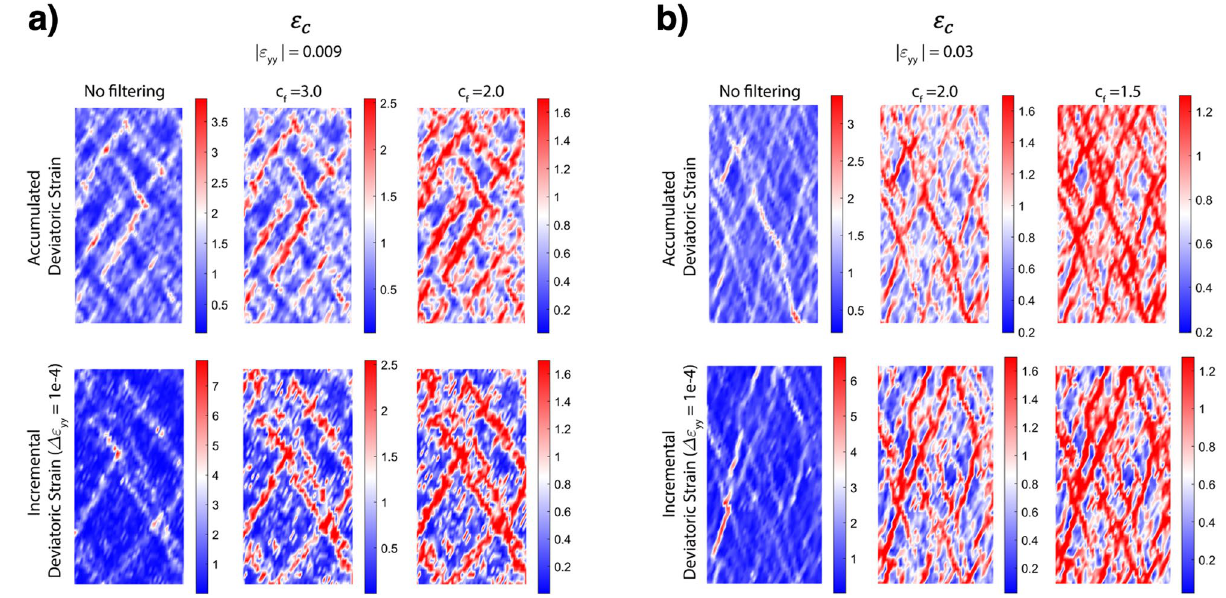
Figure 5. Spatial field of deviatoric strain (normalized to its spatial average value), ε dev ( x )/ ¯ ε dev at ε c for systems ( a ) 20K and ( b ) 20K-NR. For each sample, the top row shows the accumulated strain while the bottom row shows the field for a �ε yy = 1 e − 4 increment of strain. Second and third columns show filtered data where the values larger than the threshold c f ¯ ε dev are reduced to the threshold value for better visualization of patterns at lower